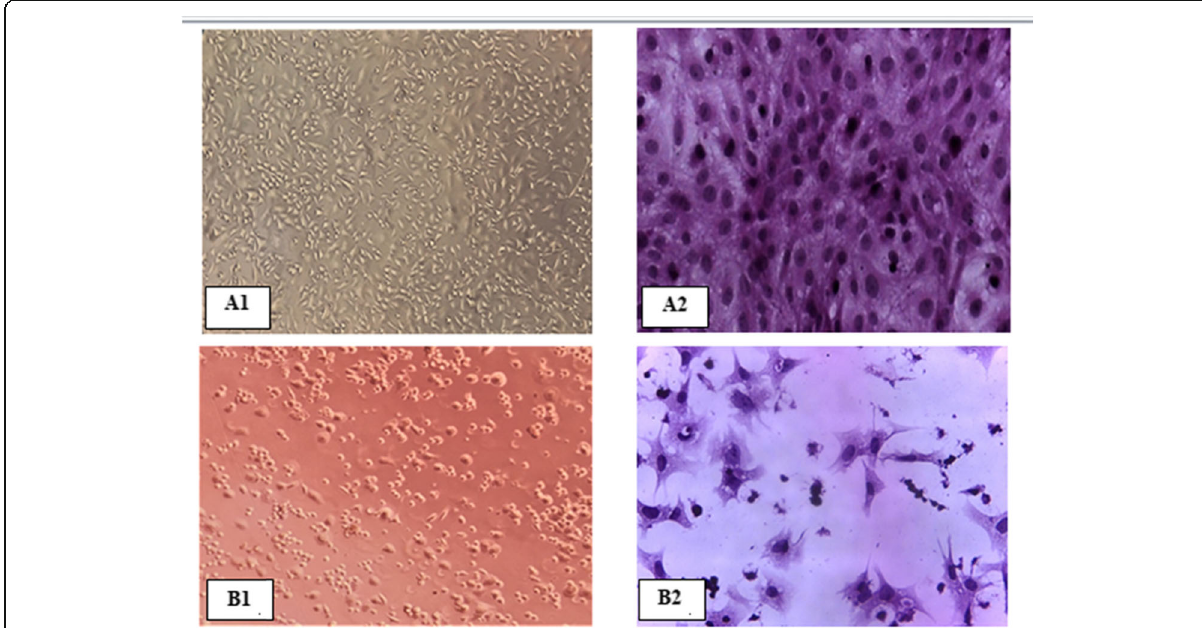
Fig. 4 Eosin and hematoxylin of staining MCF-7 cell line after 42 h. A1 Unstained control confluent monolayer. A2 Stained control confluent monolayer. B1 Unstained cells treated with 100 μ g/ml of Ag NPS. B2 Stained cells treated with 100 μ g/ml of Ag NPS